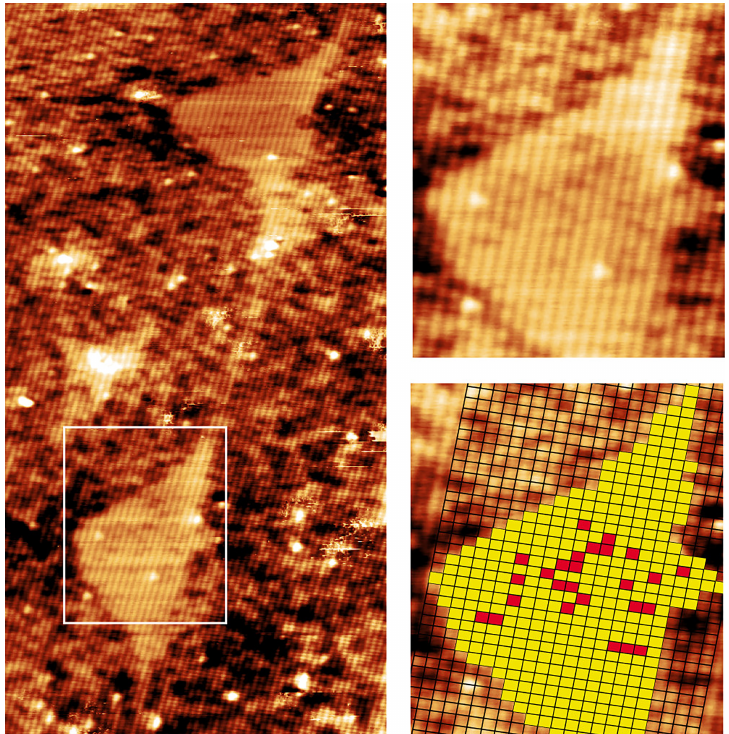
Figure 6. 30 × 60 nm 2 topographic image ( left ) of two QDs taken at V b = –3 V and I t = 40 pA. An atomic grid is overlain on top of a close up of the QD dot ( right ). Al and Ga atoms in the QD are indicated by red and yellow square respectively. Reprinted from Ref. [73], © 2010 with the permission of AIP